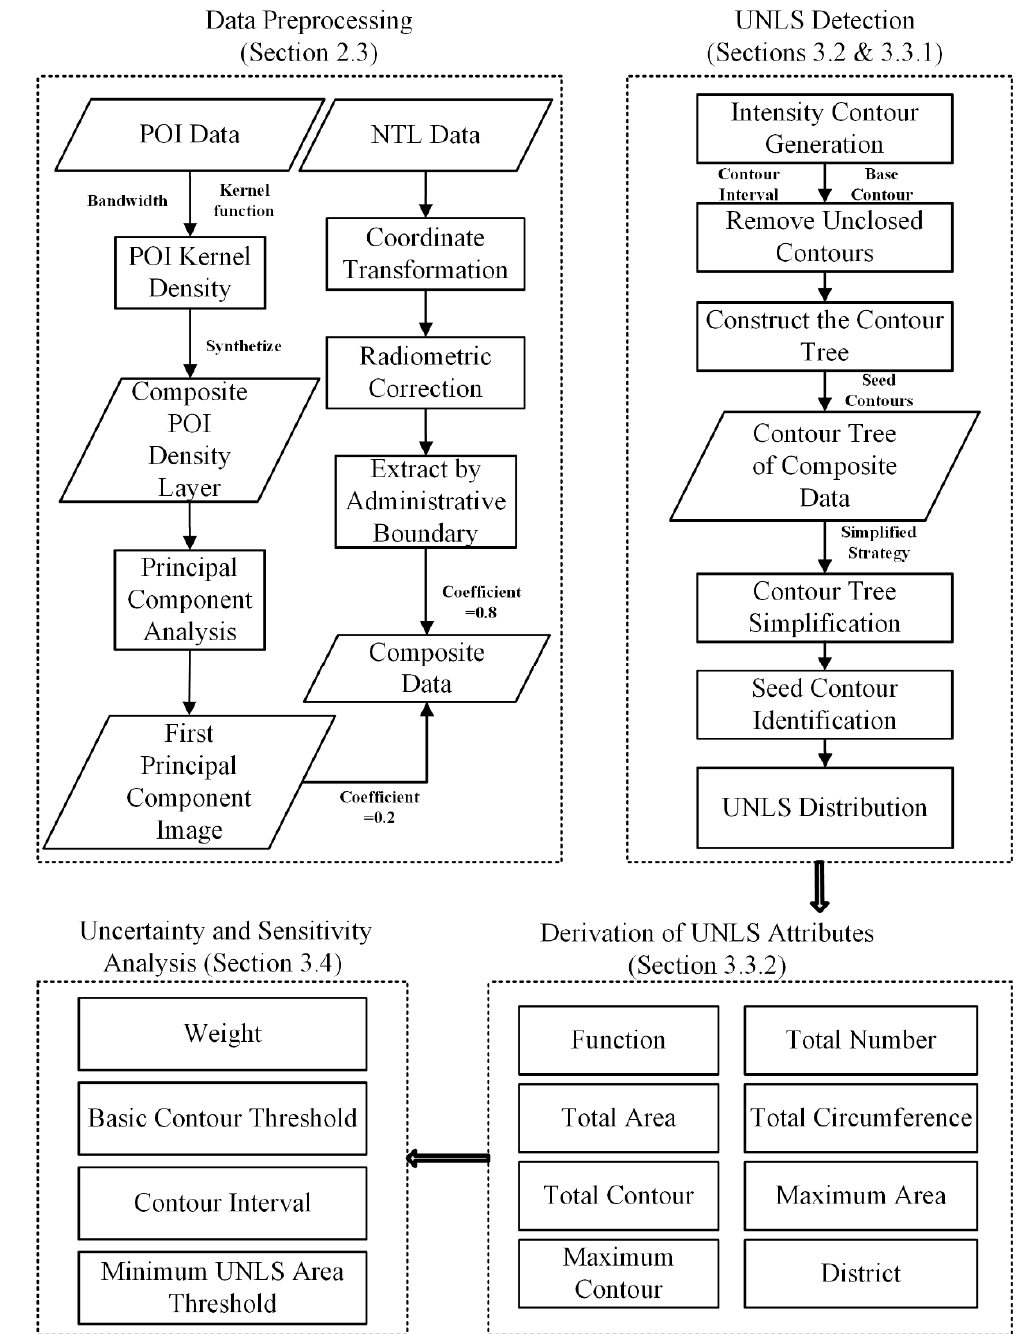
Figure 4. Flowchart of the proposed workflow for mapping urban nighttime leisure spaces (UNLSs) in Beijing,